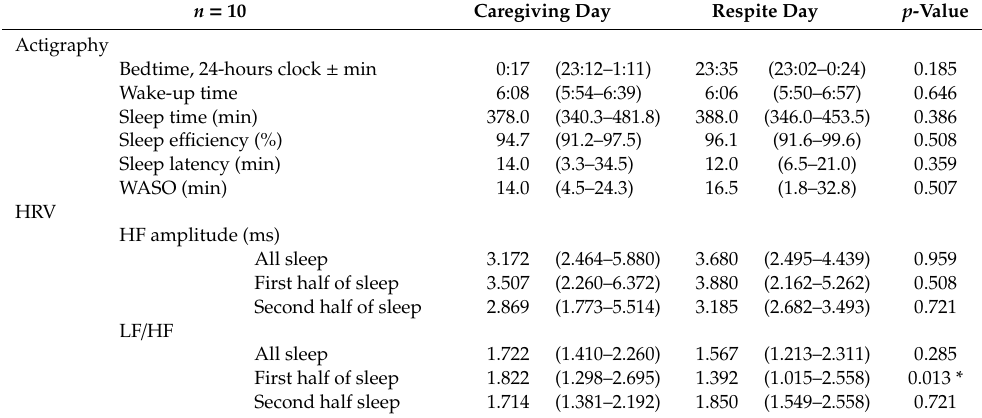
Table 2. Caregivers’ sleep status on caregiving days and respite